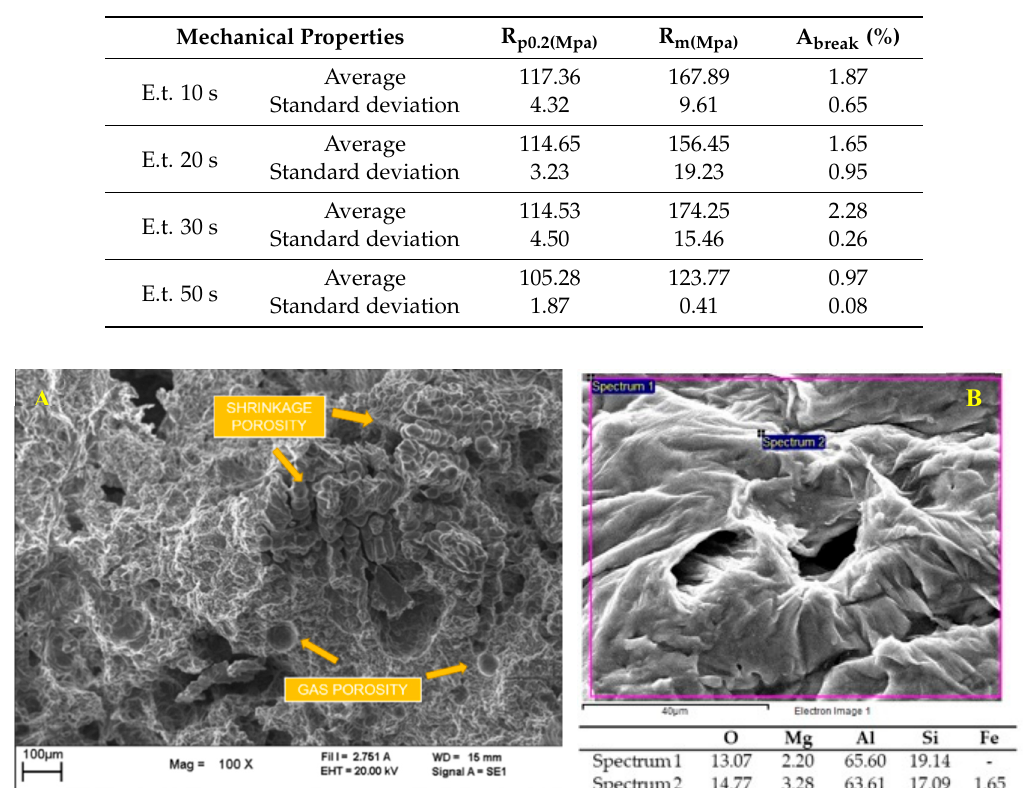
Figure 4. ( A ) Sample with fracture in correspondence of gas porosity and shrinkage porosity (SEM analysis). ( B ) Sample with presence of an oxide film (Energy Dispersive X-Ray Spectroscopy EDS analysis).